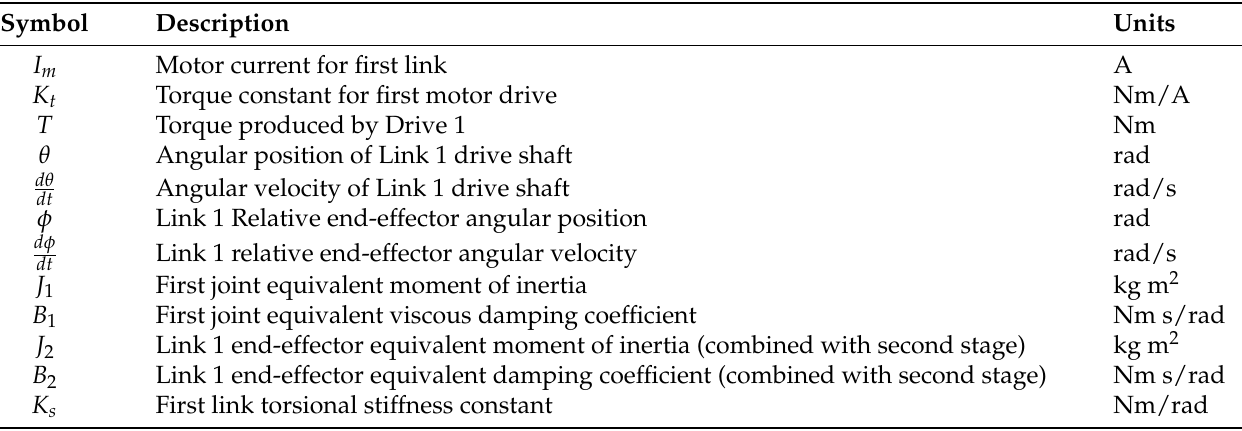
Table 1. Parameters of robotic manipulator for link 1.